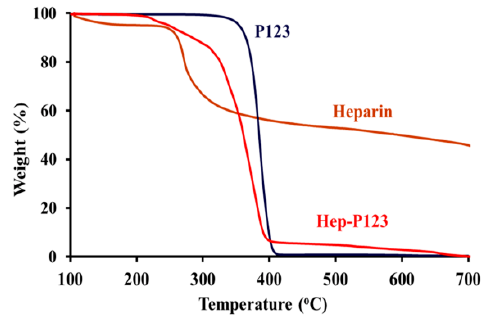
Figure 2. Thermal gravimetric analysis of P123, heparin and Hep-P123 copolymer.